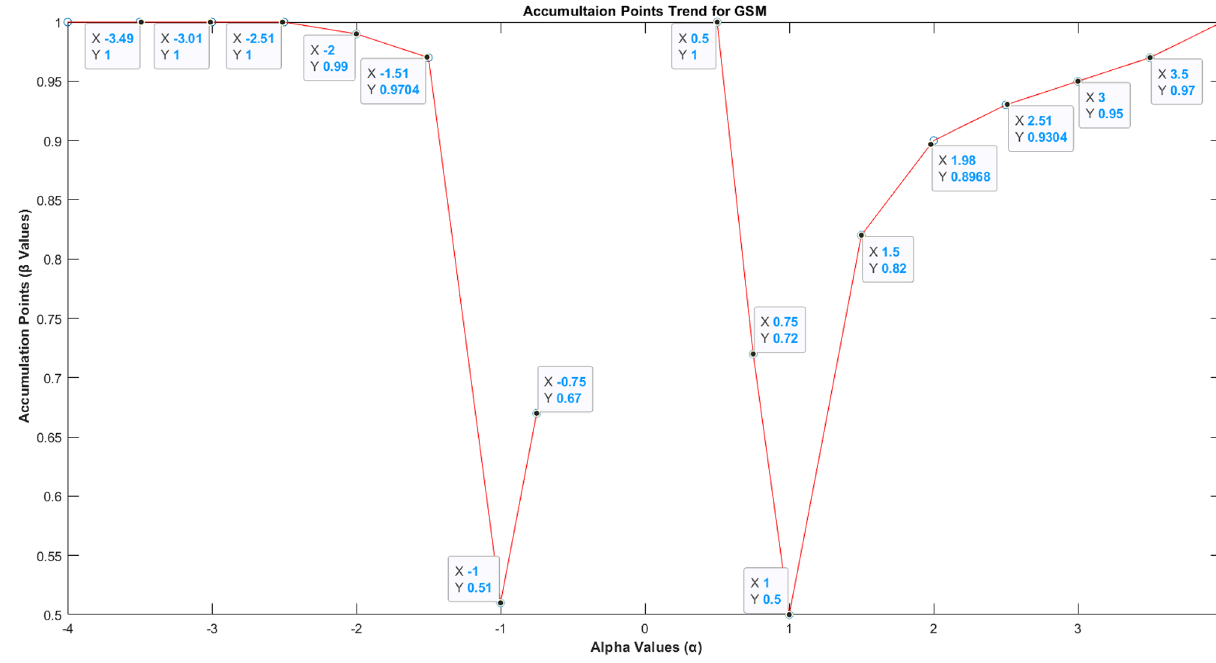
Fig. 6 Shows the trend line of 𝛼 values and respective accumulation points for